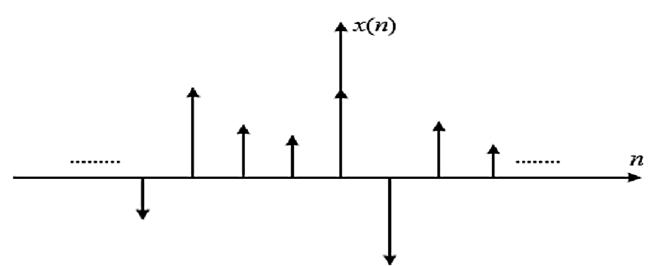
Figure 7. The input signal and its autocorrelation: ( a ) the input signal 𝑥(𝑛) to the digital LPF and ( b ) the autocorrelation 𝜙 (cid:3036)(cid:3037) (𝑡,𝑛) of the input signal 𝑥(𝑛) with 𝑖 = 𝑗 , where 𝜙 (cid:3036)(cid:3037) (𝑡,𝑛) =